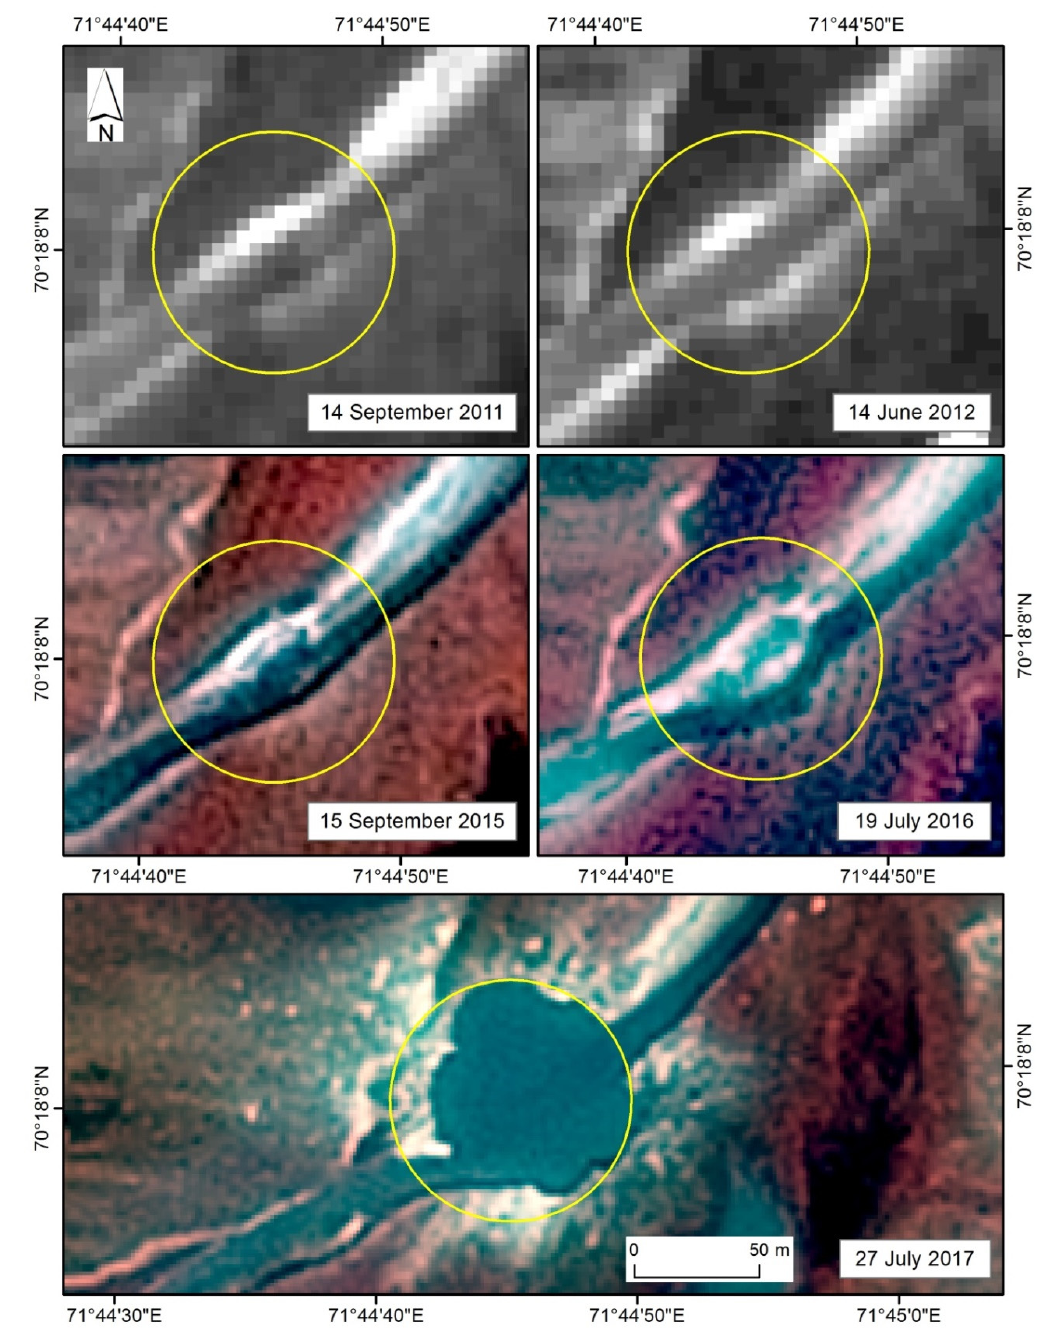
Figure 7. Changes in the morphology of the Myudriyakha river channel associated with the mound-predecessor growth and formation of SeYkhGEC. The upper row shows fragments of SPOT5 satellite imagery (5 m GSD, pan) while the middle and lower rows show imagery from SPOT7 (1.5 m GSD, synthesis of NIR+Red+Green).